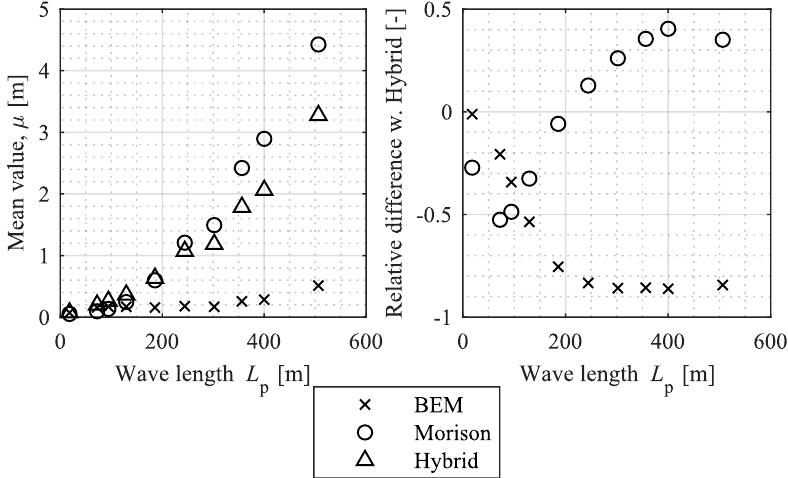
Figure 8. Mean value, µ , of the surge displacement with updated drag coefficients ( left ). The right figure illustrates the relative difference with the hybrid